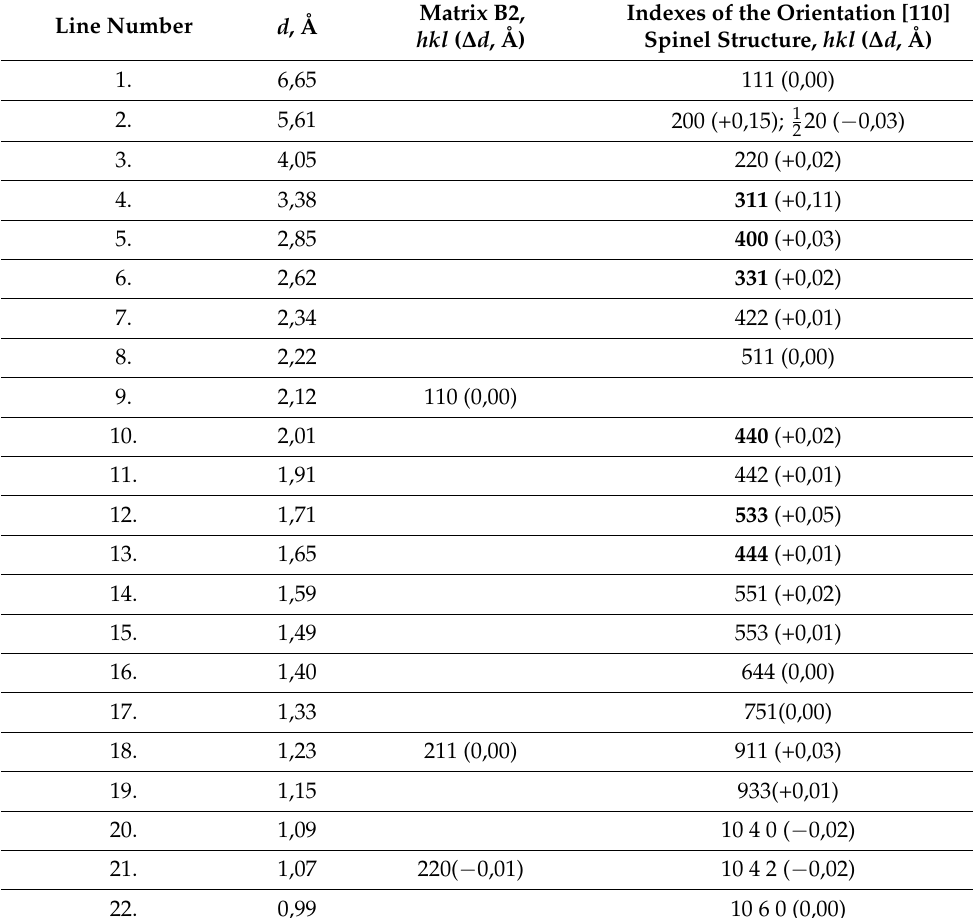
Table 2. The results of decoding the diffraction pattern shown in Figure